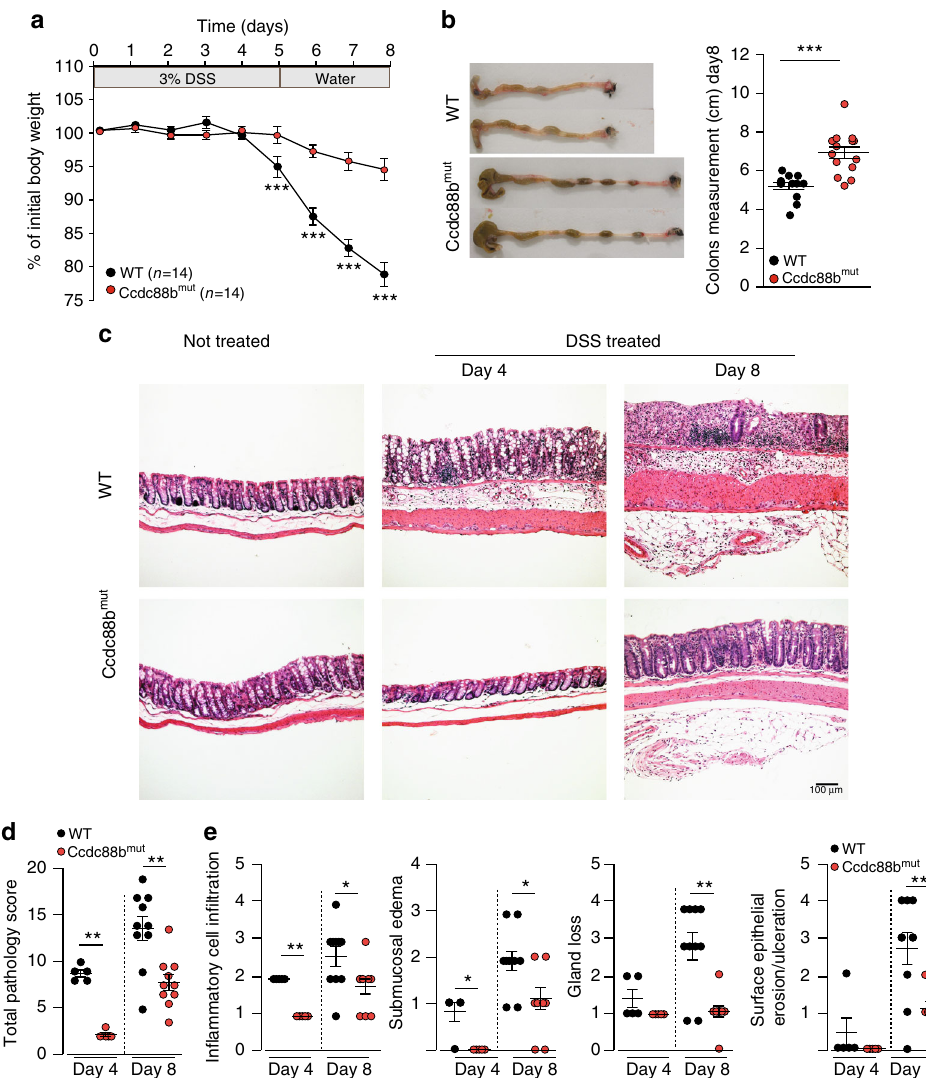
Fig. 2 Loss of Ccdc88b protects against DSS-induced colitis. a WT ( n = 14) and Ccdc88b mut mice ( n = 14) were treated with DSS (see legend to Fig. 1) and body weight loss is expressed as percent of initial weight ± SEM. *** P < 0.001 (two-tailed Student ’ s t -test). b Representative images of colons from WT and Ccdc88b mut mice at day 8, and quanti fi cation of effect of treatment on colon length ± SEM. *** P < 0.001 (two-tailed Student ’ s t -test). a , b Data are pooled from 2 independent experiments. c Hematoxylin and eosin (original magni fi cation ×10) staining of colon sections from untreated and DSS-treated WT and Ccdc88b mut mice at the indicated times. Scale bars, 100 μ m. d Total pathology score (0 – 24) from WT and Ccdc88b mut mice at day 4 after DSS treatment ( n = 5) and day 8 ( n = 10) ± SEM. ** p < 0.01 (Mann – Whitney test). e Histology scores from WT ( n = 5 for day 4 and n = 10 for day 8) and Ccdc88b mut ( n = 3 for day 4 and n = 10 for day 8) mice at indicated days evaluating in fl ammatory cell in fi ltration, submucosal edema, gland loss and surface epithelial erosion/ulceration and (Supplementary Table 1) for scoring details (mean ± SEM; * P < 0.05, ** P < 0.01, and *** P < 0.001; Mann – Whitney